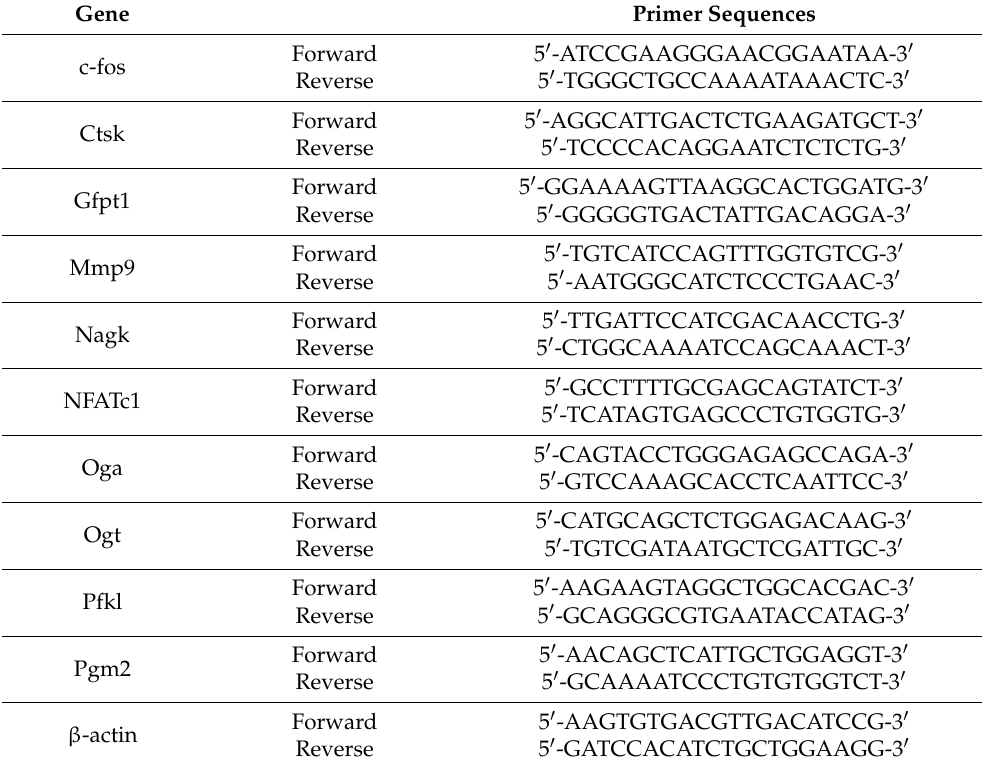
Table 1. PCR primers used in this